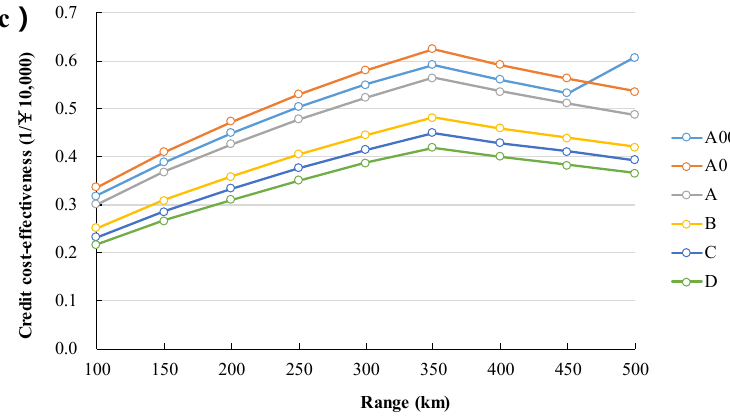
Figure 6. ( a – c ) The credit cost-effectiveness under NEV credit regulation in 2018, 2020, and 2025.